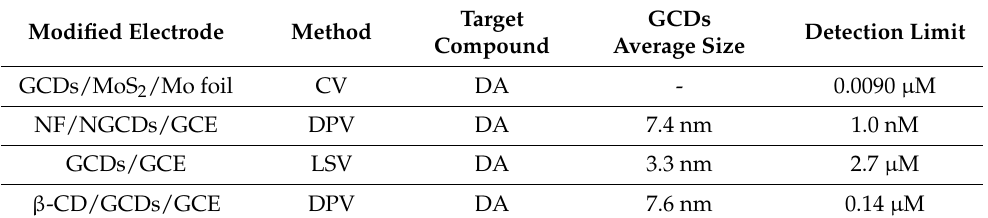
Table 8. DA detection using different GCDs-based sensors